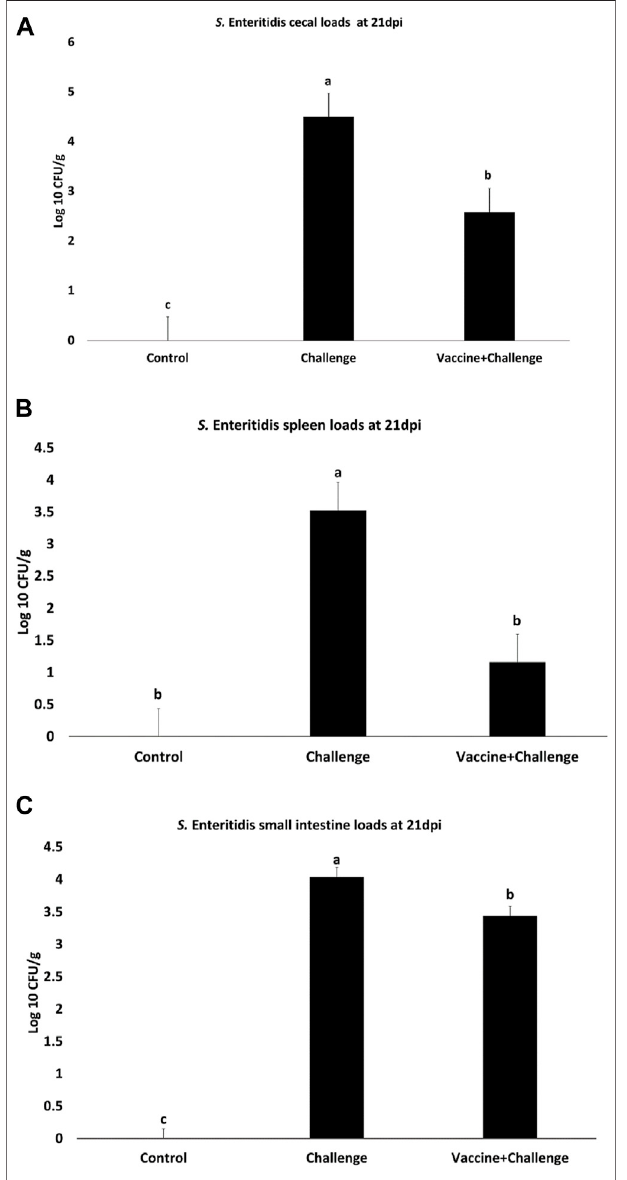
FIGURE 2 | Salmonella loads in the ceca, spleen, and small intestines of vaccinated birds. Organ samples were collected from 1 bird per pen ( n = 6) at 21dpi.Sampleswereanalyzedfor S .Enteritidisloadsbyplating.Samplesthat were double negative for S . Enteritidis presence after selective enrichment were considered negative for Salmonella colonization. Data were recorded as CFU/g of organ and transformed to Log 10 CFU/g of organ for statistical analysis. (A) Ceca; (B) Spleen; (C) Small intestine. Bars (+SE) with no common superscript differ ( p < 0.05).